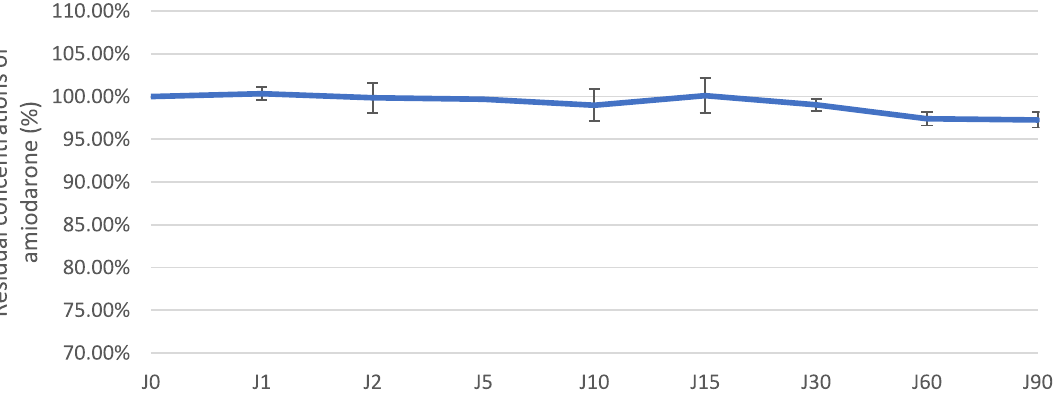
Figure 5: Chemical stability of amiodarone oral suspension. Values are expressed as mean percentage remaining ± standard